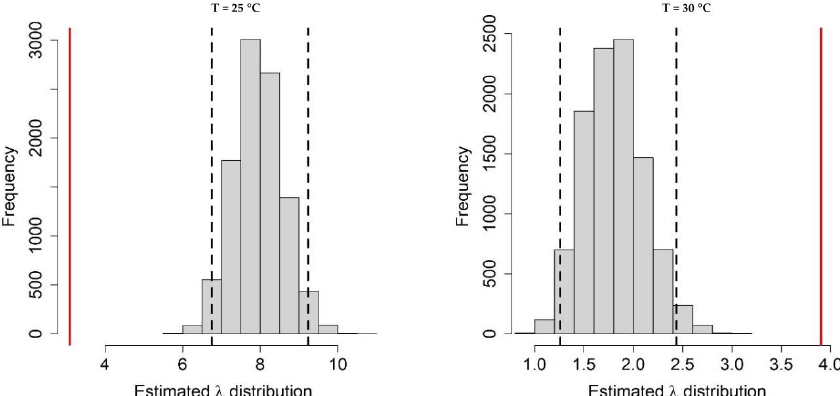
Figure A7. Estimated posterior distributions of Λ NG (T), the number of gonotrophic cycles completed on average by a female mosquito at 25 and 30 °C. Dashed black lines represent the 2.5 and 97.5 quantiles. Solid red lines represent the average value for subtropical Ae. albopictus .